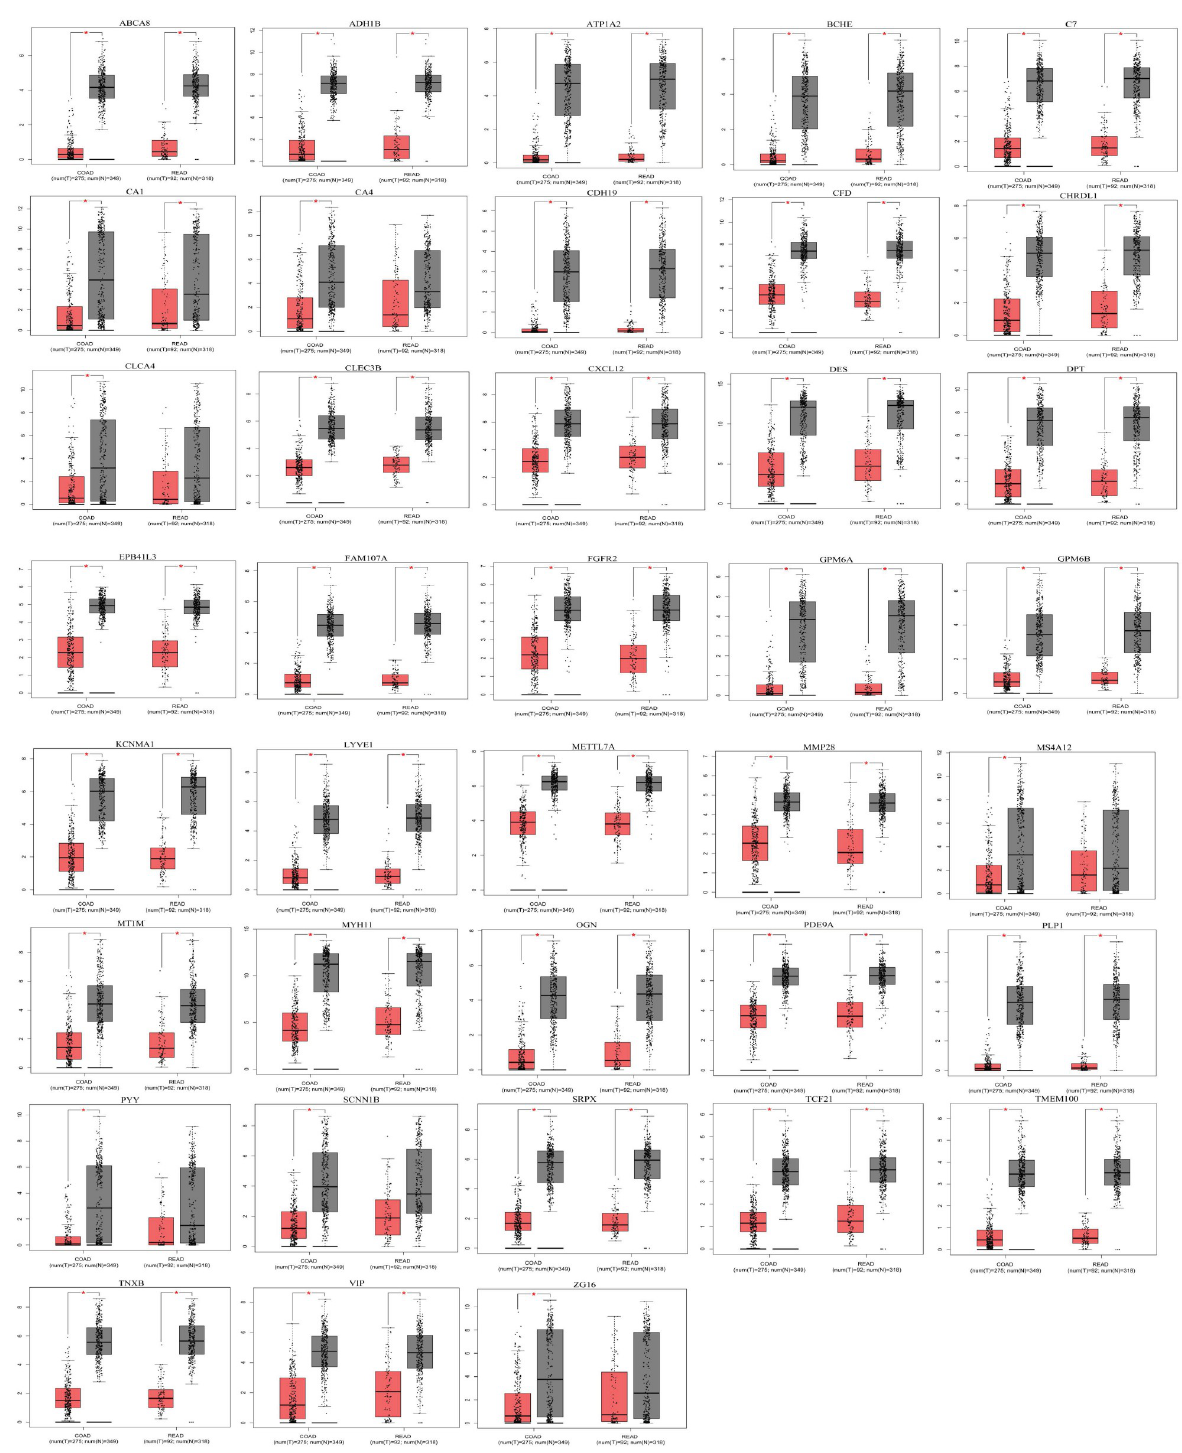
Fig 16. Expression box plots of statistically significant under-expressed validated Differentially Expressed Genes based on TCGA data.